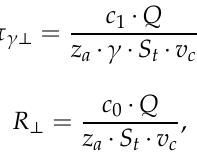
Figure 3. Relation between cutting power per one saw blade and uncut chip thickness when sawing pine wood dried with different methods: PA—air drying, PC—conventional kiln drying, PS—warm heated-steam experimental drying, PV—vacuum kiln drying. The evident effect of wood density ρ [54,55] can be compensated by normalizing values of resulting mechanical parameters [41]. Diverse algorithms can be implemented for the data unification and further non-biased interpretation. The approach adopted for the need of this study included correction of the measured cutting power by the variation related to the average wood assessed individually for each processed board. Consequently, Equation (5) was revised as follows (Equation (11)), assuming that P ac and P dull can be neglected for the cutting process on the frame saw: ργτ γ ⋅⋅+⋅⋅⋅ ⋅ ⋅⋅ == c p tp cwcT vRh tQ SHm PP )( ** , (11) Two novel meta variables were introduced here that correspond to normalized fracture toughness R * ⊥ [J m kg − 1 ] and normalized shear yield stress in the shear zone τ * γ ⊥ [MPa m 3 kg − 1 ]. Equation (11) can, therefore, be expressed as a lineal equation by following the same logic as used for deriving Equation (8). In that case, the cutting power related to the wood density as a function of the chip thickness h is presented in Equation (12): 01 * )()( chch P hP cw cw +⋅== ρ , (12) The experimental values of the cutting power per one saw blade P cw * normalized by density are shown in Figures 5 and 6 for pine and beech, respectively. It is evident that the standard deviation ranges are noticeably reduced compared to the not-normalized results. It is confirmed by higher values of determination coefficients r 2 in the majority of investigated cases. This phenomenon confirms the hypothesis of the direct correlation of the density and fracture properties of wood. However, it is also clear that considering density only does not lead to complete elimination of the experimental data scatter. It was previously observed by Chuchala et al. [56] that the effect of density